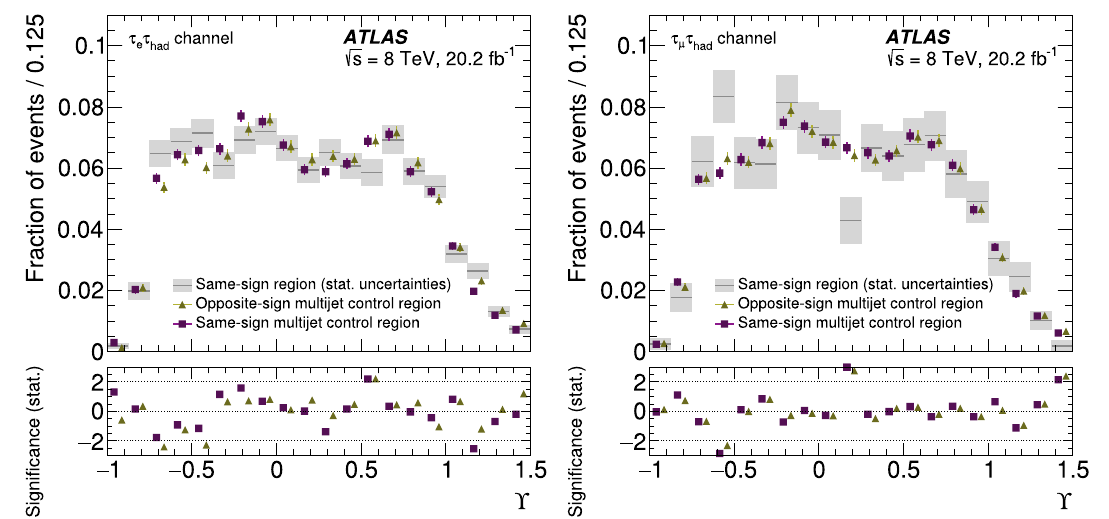
Fig. 3 Multijet templates obtained in the same-sign region and in the opposite- and same-sign multijet control regions in the τ e – τ had (left) and τ μ – τ had (right) channel. Only statistical uncertainties are shown.